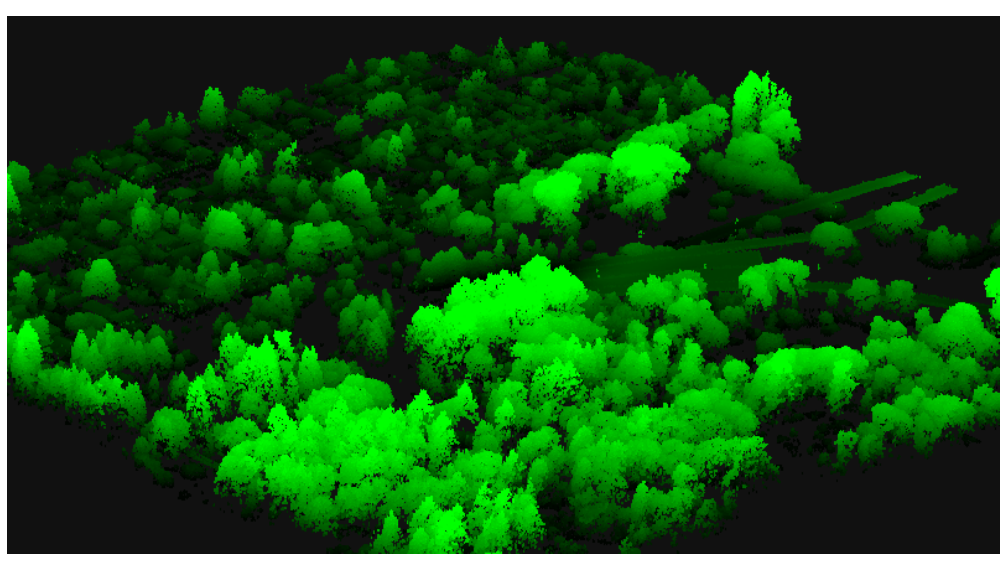
Figure 3. Three-dimensional plot of discrete point Lidar data extracted from waveform Lidar data. This view is looking northwest at the area outlined with a tan colored dotted line in Figure 2. This image shows the variable density of the trees in the University of Washington Arboretum. A thicker patch of black cottonwood and red alder is visible in front of the elevated freeway ramp. Most of the crown of larger conifers are visible in other parts of the image. Outside the Arboretum, many neighborhood streets and power lines are visible.